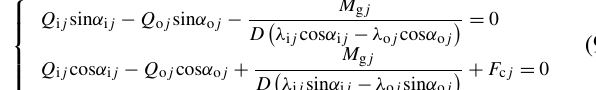
Figure 3. Geometric relations in ball bearing. (a) Angular position of rolling ball. (b) Displacement of the j th rolling ball.